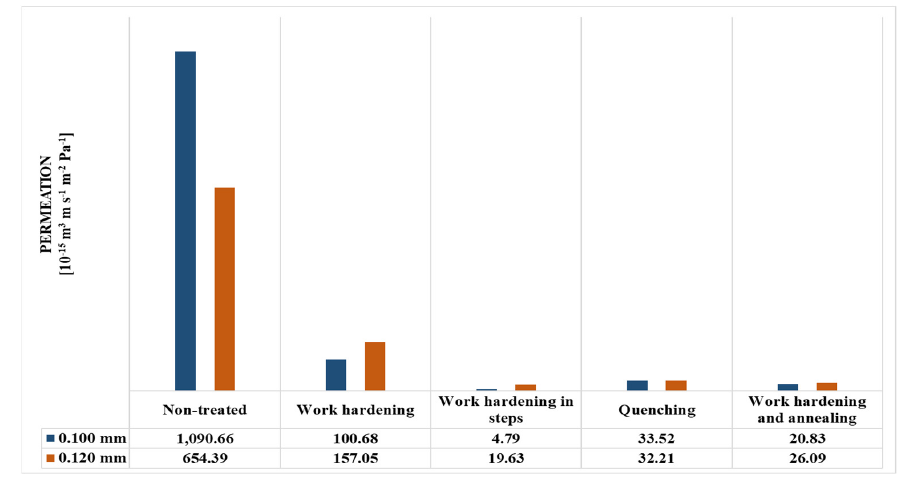
Figure 13. Permeation values (in m 3stp m s − 1 m − 2 Pa − 1 units) of metal membranes.